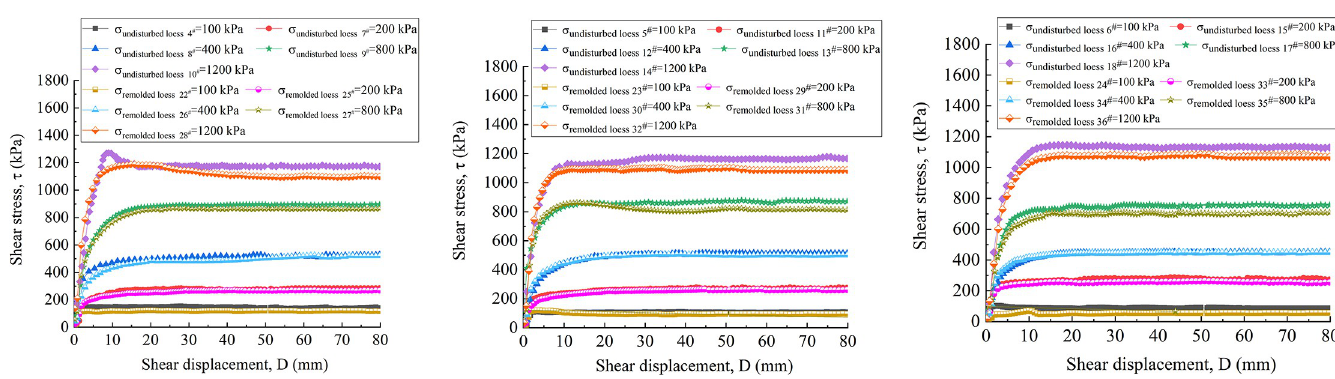
Fig 17. Shear stress-shear displacement curve of 4 # -18 # undisturbed and 22 # - 36 # remolded loess specimens under different vertical pressure. (A) Shear stress- shear displacement curve of 4 # , 7 # - 10 # undisturbed and 22 # , 25 # -28 # remolded loess specimens ( w = 16%). (B) Shear stress-shear displacement curve of 5 # , 11 # - 14 # undisturbed and 23 # , 29 # -32 # remolded loess specimens ( w = 19%). (C) Shear stress-shear displacement curve of 6 # , 15 # - 18 # undisturbed and 24 # , 33 # -36 # remolded loess specimens ( w = 22%).